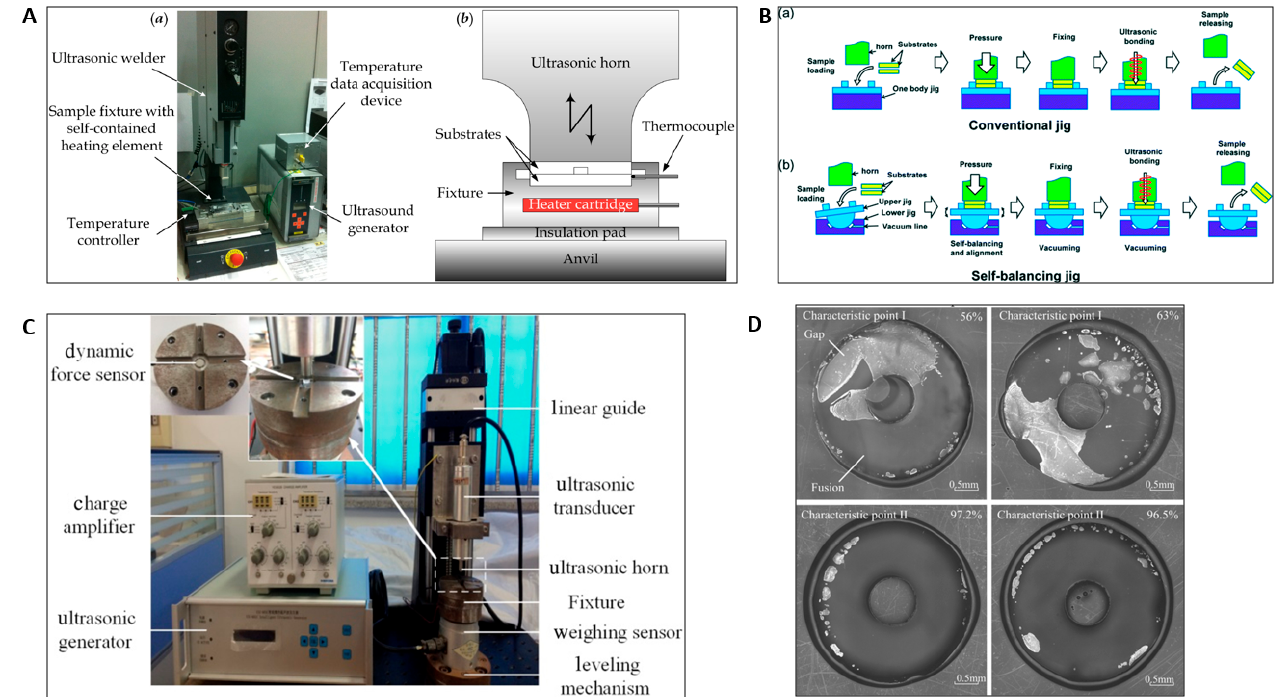
Figure 5. ( A ) ( a ) Ultrasonic bonding complete setup. ( b ) Schematic diagram of ultrasonic bonding